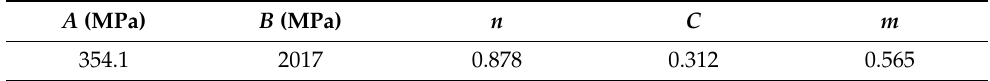
Table 1. Parameters for the JC model for the GH3230 superalloy double-sheet. A